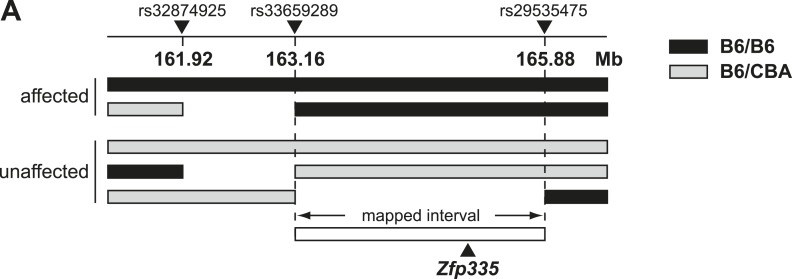
Linkage mapping of bloto mutation to a 2.72 Mb region on chromosome 2
containing Zfp335.(A) Black bars represent B6 homozygosity and gray bars
represent B6/CBA heterozygosity as determined by SNP analysis. Data from
two affected and three unaffected F2 progeny shown.